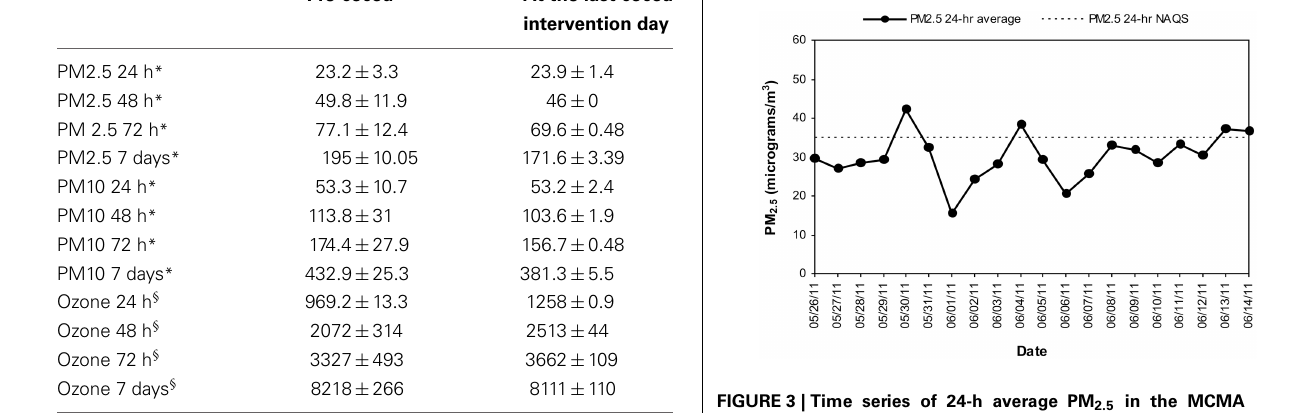
FIGURE 3 | Time series of 24-h average PM 2 . 5 in the MCMA children’s residency area from May 26 to June 14, 2011. The dashed line shows the US EPA NAAQS value of 24-h average PM 2 . 5 concentration which stands for the 98th percentile value of all days in the